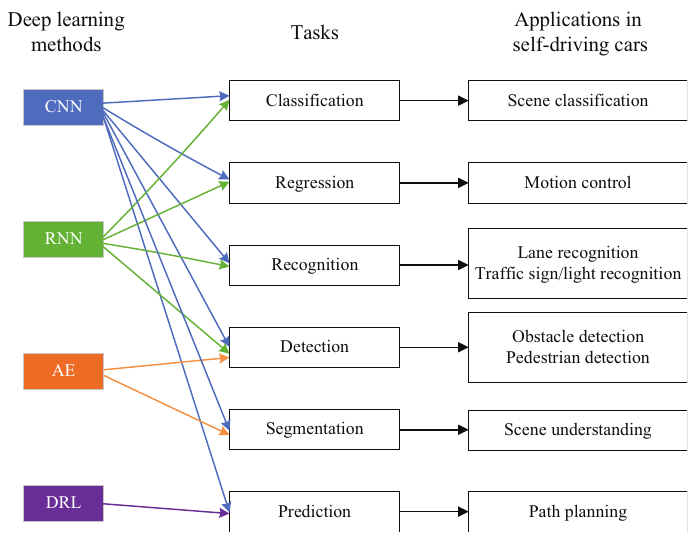
Figure 9. The classification of the deep learning methods used in the field of self-driving